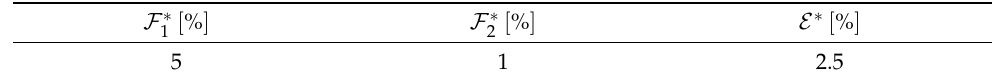
Table 2. Upper bound values for the constraints.